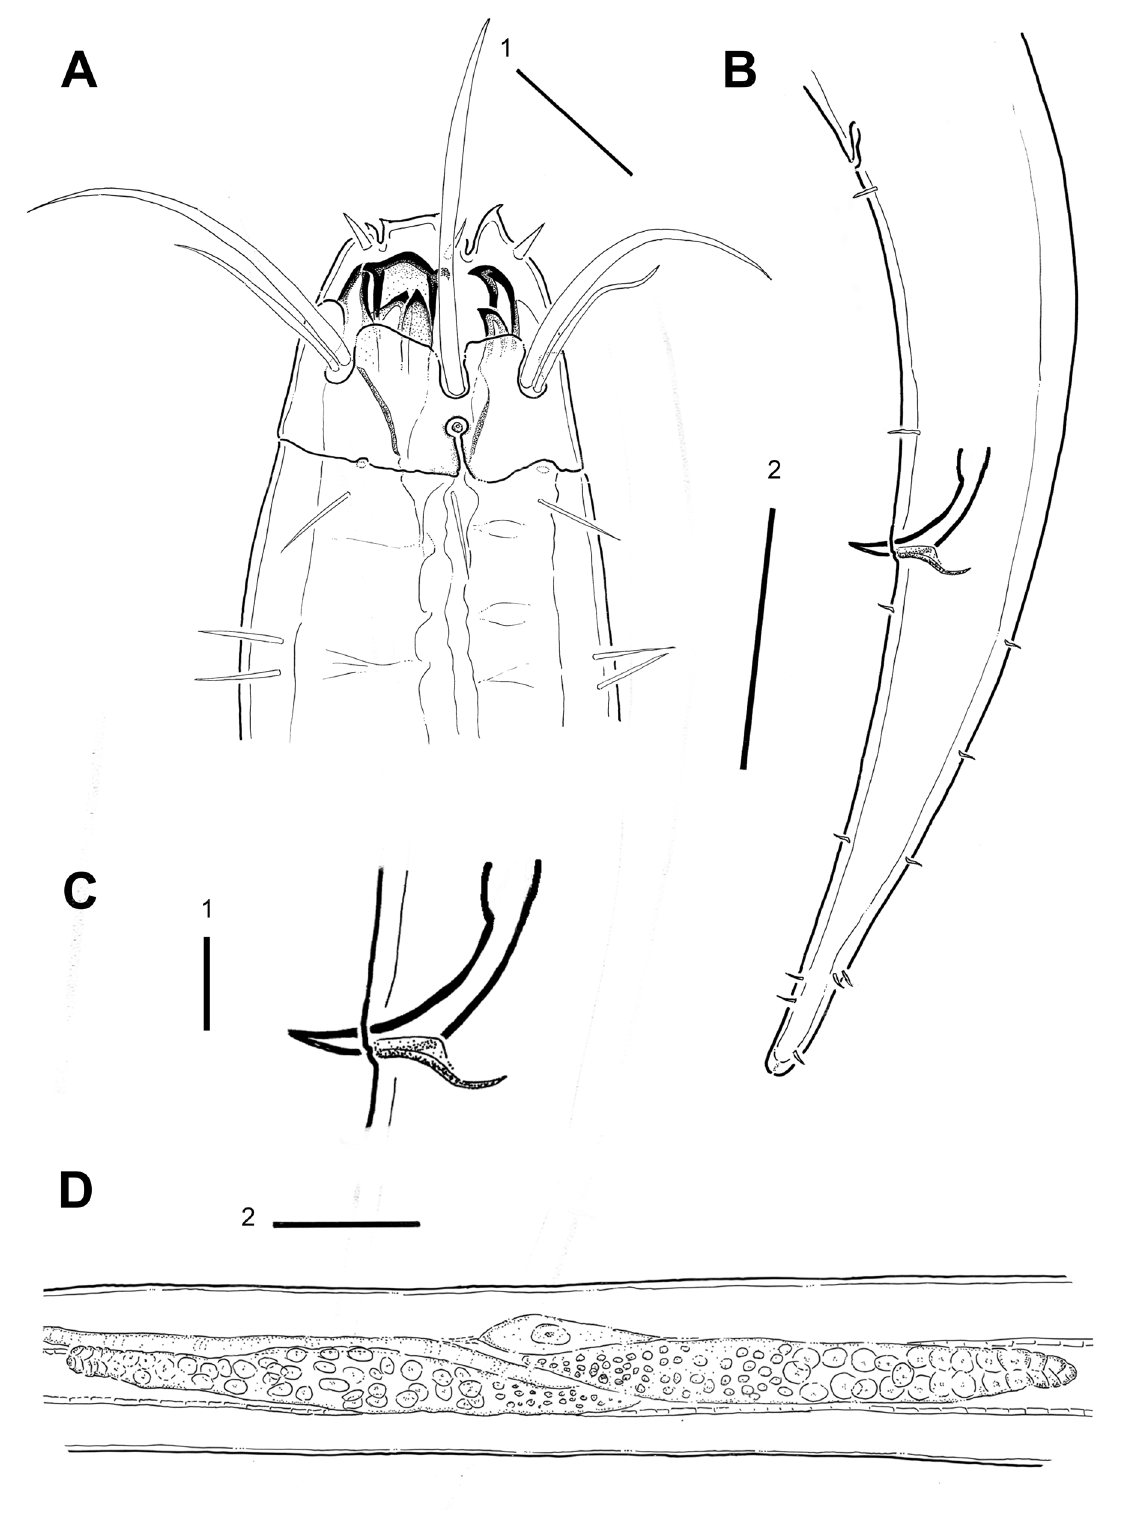
Fig. 4. Mesacanthion sanantoniensis sp. nov., ♂, holotype (CNP-NEM 849). A . Cephalic sense organs on anterior end. B . Posterior end, showing copulatory apparatus and precloacal supplement organ. C . Copulatory apparatus, spicules and gubernaculum. D . Gonads. Scale bars: 1 = 20 μm; 2 = 100